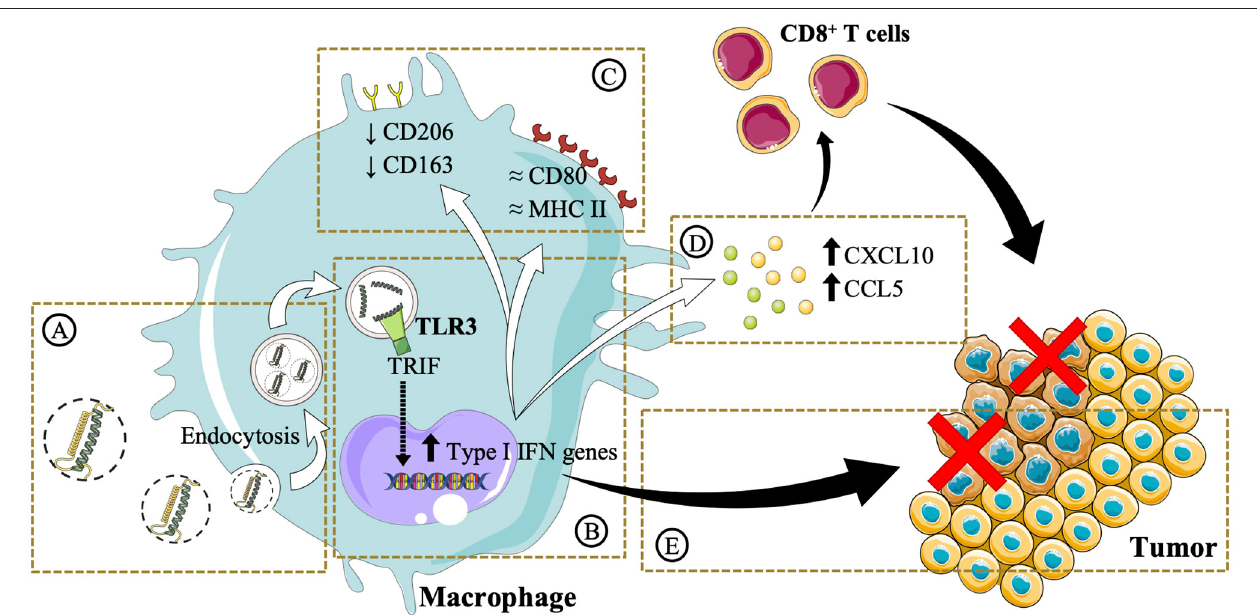
FIGURE 8 | Schematic illustration of the in vitro effects of the poly(I:C) ENCPs developed in this study. (A) Upon interaction with macrophages, poly(I:C) nanocomplexes are taken up. (B) This process allows poly(I:C) to reach its target receptor TLR3, found in the endosomes. It is expected that this interaction activates the TLR3 and the TRIF pathway, stimulating the upregulation of type I IFN genes. (C) The expression of M2 (CD206 and CD163) surface markers was slightly decreased, while M1 (CD80 and MHC II) markers are not substantially modified. Nevertheless, (D) CXCL10 and CCL5 chemokines, involved in the attraction of CD8T cells to the tumor microenvironment, are secreted. (E) The direct cytotoxicity of macrophages toward cancer cells is also enhanced. Images were reproduced from Servier Medical Art under a Creative Commons Attribution 3.0 Unported License